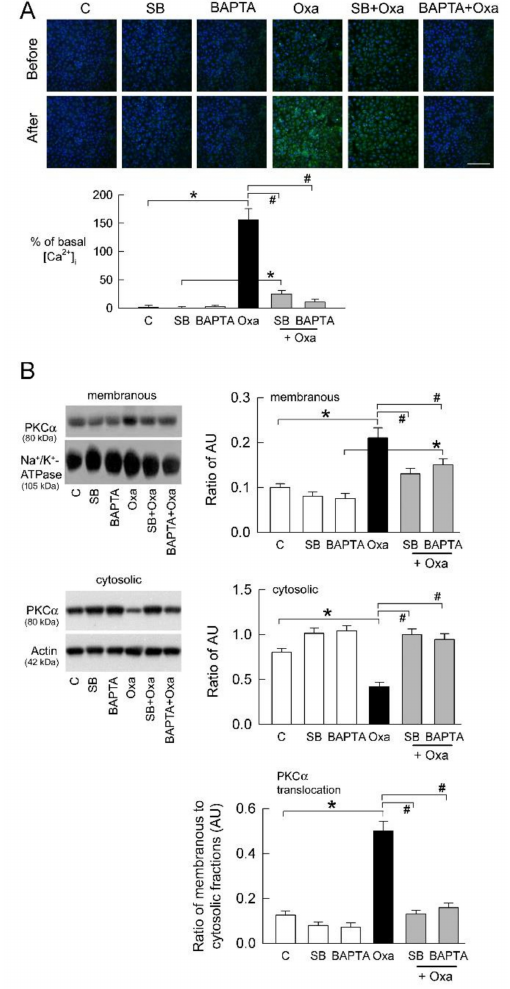
Figure 2. TRPV1 inhibition and Ca 2+ chelation attenuates oxalate-mediated PKC α activation in tubular cells. ( A ) Example of merged pictures of Fluo-3-loaded LLC-PK 1 cells with various treatments at 200 × magnification (green). Nuclei are counterstained with DAPI (blue). White scale bar is 800 µ m. Lower bar graph shows percent changes in [Ca 2+ ]i of control (C) group (n = 6 per group). Note that a significant increase in Fluo-3 fluorescence following 24 h of 0.5 mM oxalate (Oxa) treatment is attenuated by TRPV1 blocker SB and Ca 2+ chelator BPATA. C, control. ( B ) Representative blots are shown for PKC α in cell membrane (right upper blots) and cytosolic (right lower blots) fraction. Equal amounts of 40 µ g protein per lane from each sample were loaded, as confirmed by similar expression of Na + , K + -ATPase, and actin in membranous and cytosolic fractions, respectively. Relative levels of PKC α were assessed by densitometry as ratio of PKC to Na + , K + -ATPase (left upper bar graph) or actin (left middle bar graph). Note that oxalate induces a significant increase in membranous distribution and a reduced cytosolic fraction of PKC α . These were attenuated by TRPV1 blocker SB and Ca 2+ chelator BPATA. * p < 0.05, Oxa vs. control (C) group; # p < 0.05 vs. Oxa group without blocker treatment. One-way ANOVA was applied for statistical comparison in all